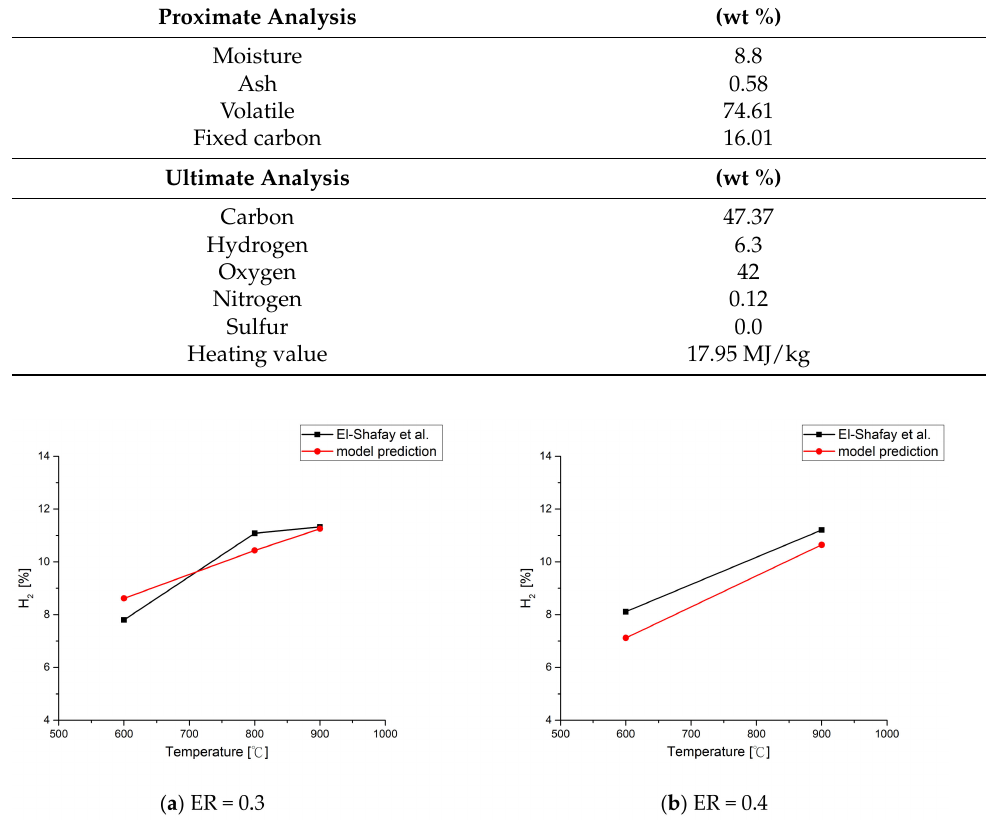
Figure 7. Comparisons of the results of the H 2 [%] model prediction with those of El-Shafay et al. [58] for different ER and